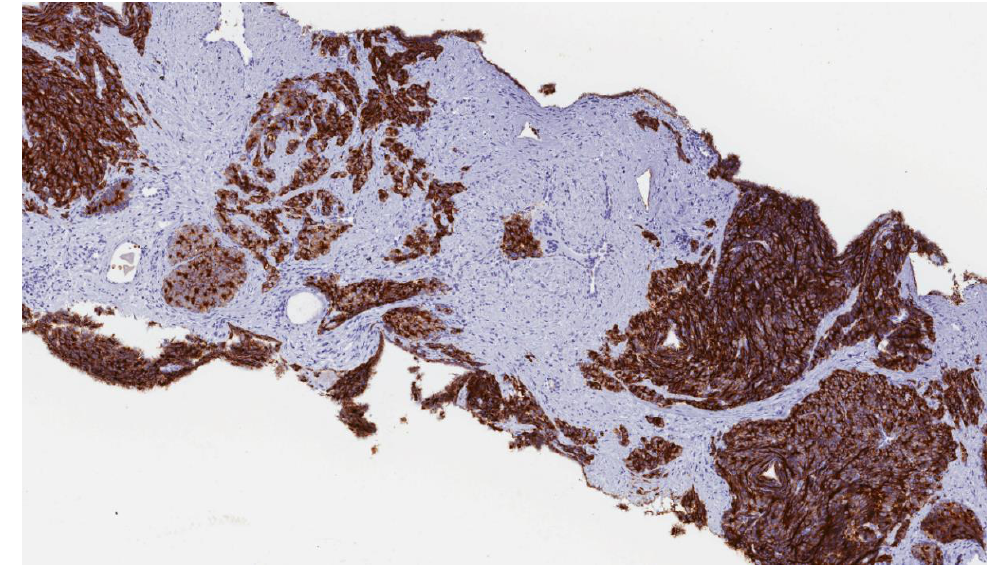
Figure 2. Biopsy sample of prostate tissue infiltrated by prostatic adenocarcinoma, with a strong and diffuse prostate specific membrane antigen (PSMA) expression. (magnification: 4 ×